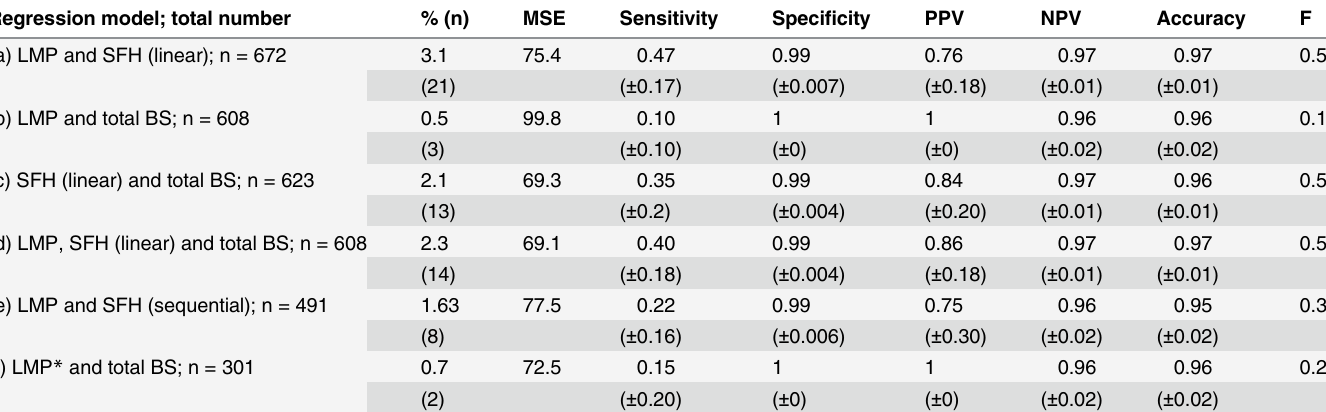
Table 5. Multiple Regression Models and Performance in Predicting Gestational Age and Preterm Birth. Regression model; total